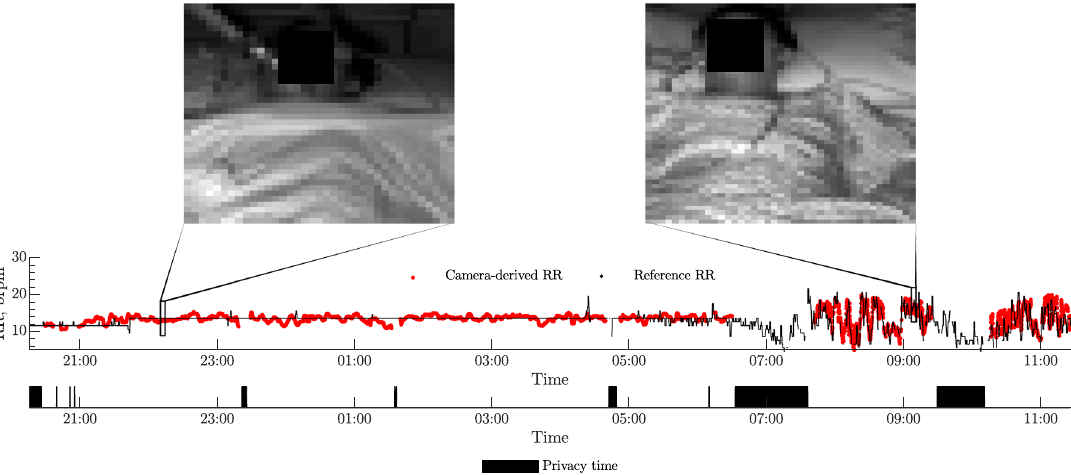
Fig. 4 Respiratory monitoring of a patient over a 14-h period. The video camera-derived estimates (in red) are compared against the reference values provided by the bedside monitoring equipment (in black). Periods during which the privacy blind was drawn, and thus video monitoring was interrupted due an obstructed camera view of the patient, are shown in the bottom panel. Sample frames from the video camera recording during invasive respiratory support and after extubation are shown as inserts at t = 22:15 and t = 09:15.